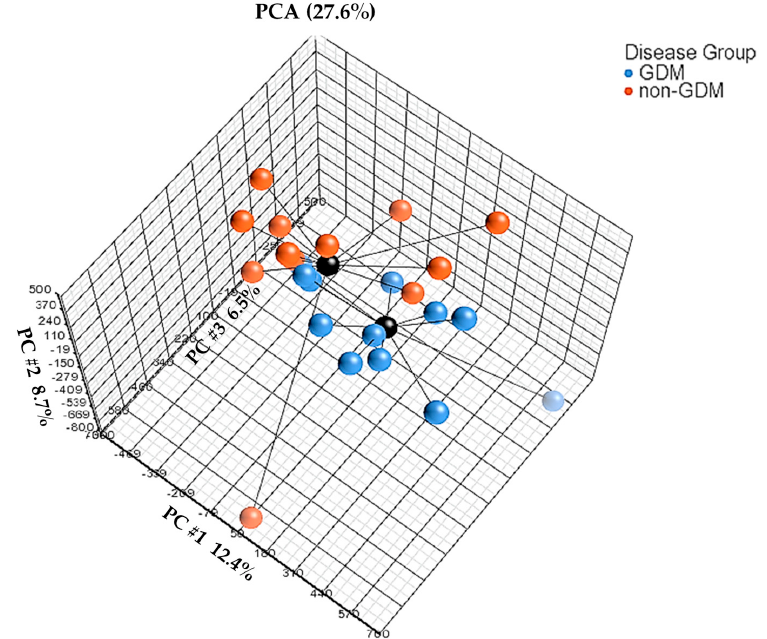
Figure 2. Principal component analysis (PCA) between GDM and non-GDM groups. Each dot represents a sample. Centroids (black) connect samples from the respective GDM (blue) or non-GDM (red) group and indicate the center of distribution, while the black bars indicate the distance between samples and centroids. The first three PCAs explain 27.6% of the variance.